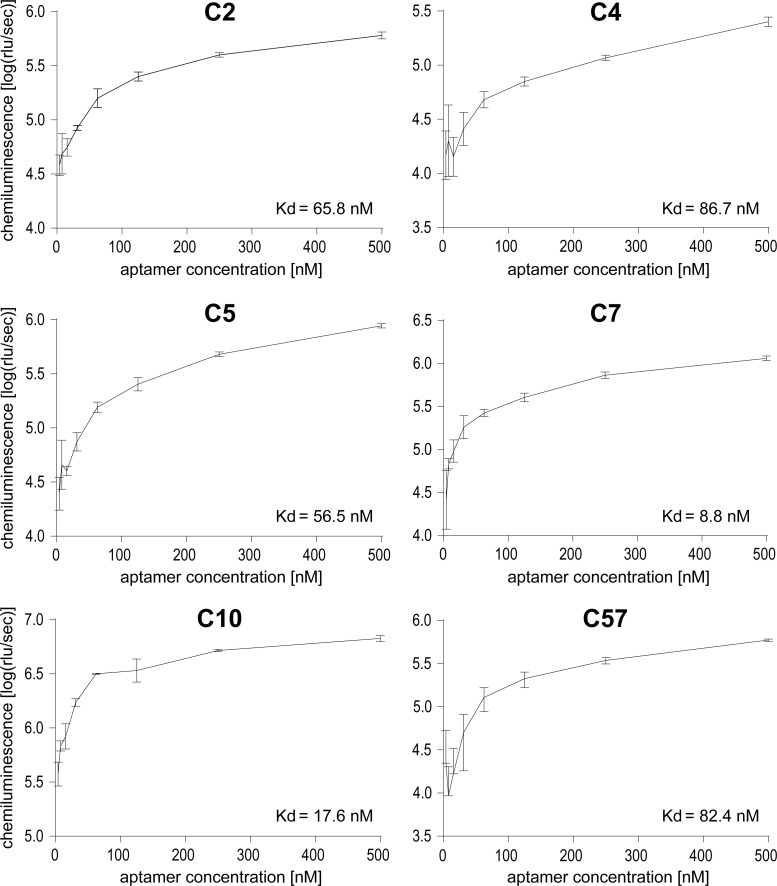
Titration of aptamers for heat-treated rituximab binding using ELASA.Rituximab was incubated at 80°C for 1 minute and bound to immobilized protein A. Aptamers were applied in working concentrations ranging from 4–500 nM. Mean chemiluminescence and standard deviations of three replicates per aptamer dilution are presented.